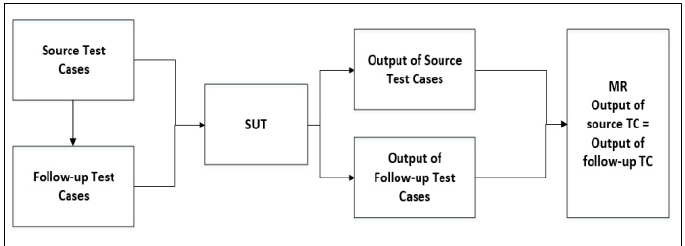
Figure 1. Process of metamorphic testing.